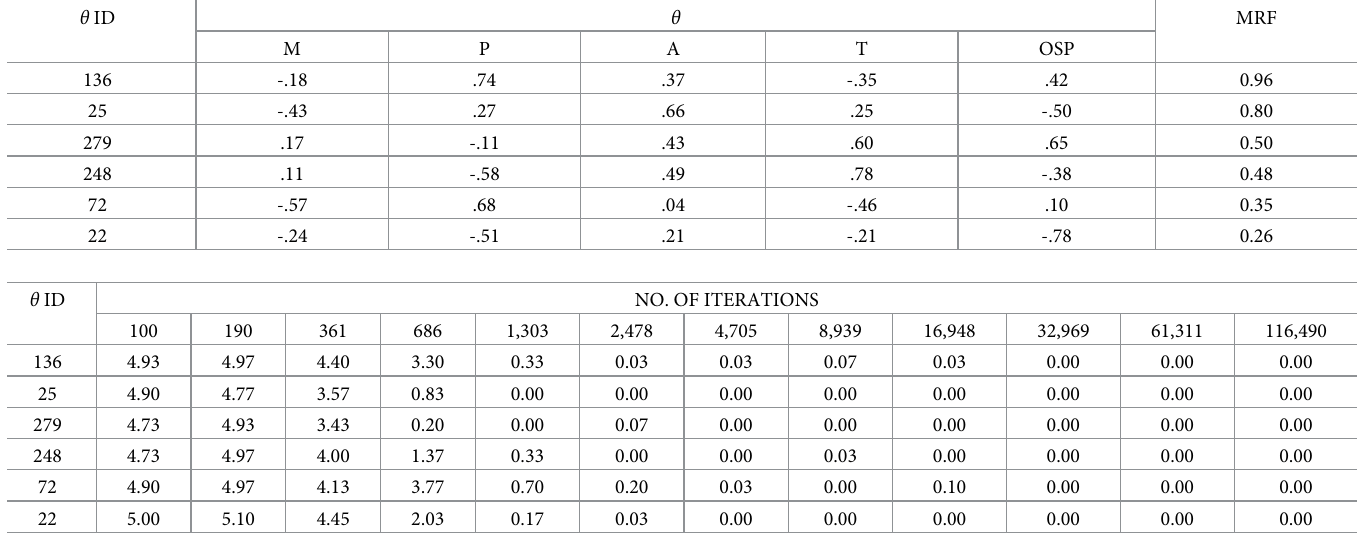
Table 2. Mean number of inconsistent blocks and mean RF values with the corresponding parameter values. For those θ s which generated networks with the mean number of inconsistent blocks at 32,969 iterations equal to zero. Initial is an empty network. θ ID